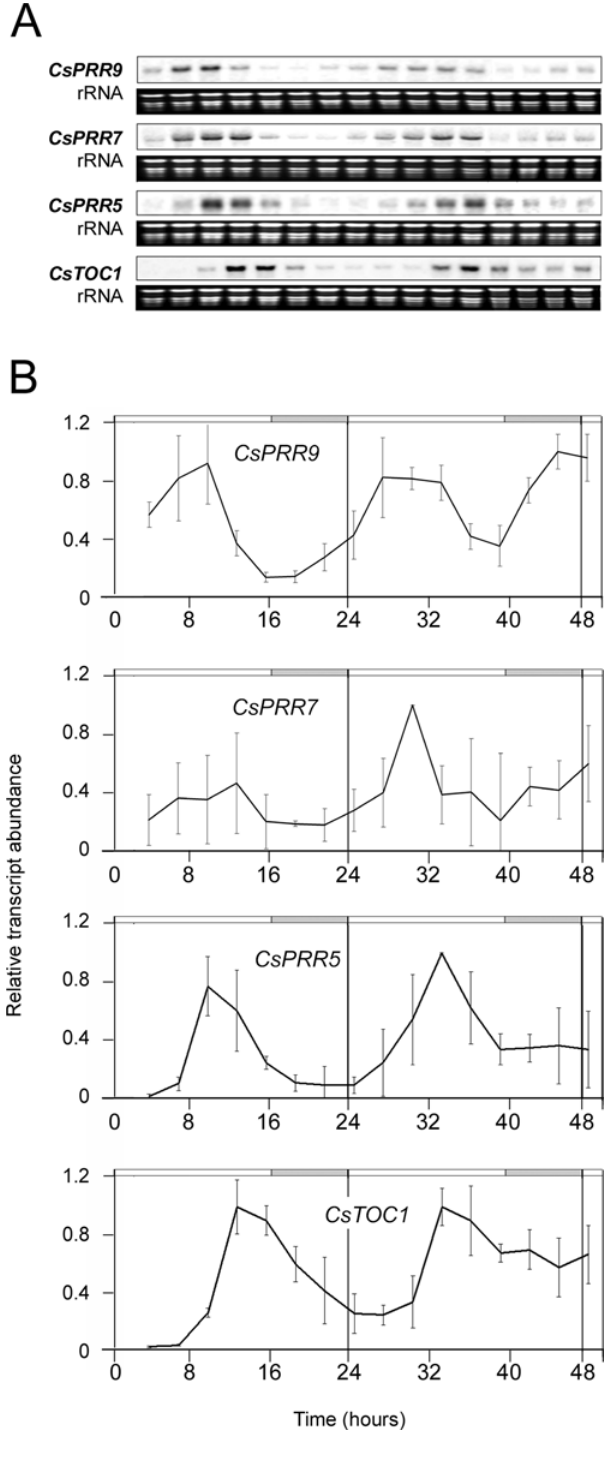
Figure 2. CsPRR gene expression levels in chestnut leaves under LL conditions. CsPRR gene expression rhythms observed in leaves taken from 16- to 24 week-old chestnut seedlings grown under standard conditions (LD, 22 u C) subsequently transferred to conditions of LL and 22 u C. Samples were collected at 3-h intervals. (A) Northern blot analysis. The rRNA loading reference was detected by staining gels with ethidium bromide. (B) Quantitative RT-PCR analysis. Relative transcript abundances are shown in the graphs. Data are means from three biological replicates. The open and shaded bars above the graphs represent subjective day and night lengths, respectively.